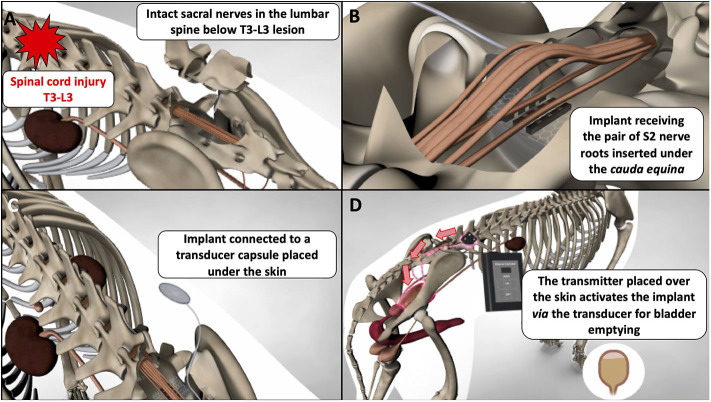
Schematic demonstrating placement and function of a canine sacral nerve stimulator for bladder emptying in chronically paraplegic dogs; (A) in dogs with T3-L3 spinal cord lesions, the sacral nerves below the lesion remain intact and can be accessed via lumbo-sacral laminectomy; (B) a “book” electrode containing two gutters can receive a pair of sacral nerves (e.g., the S2 pair) when the implant is slotted underneath the dural cone and cauda equina; (C) the implant is connected via a cable (named a Cooper cable) to a sub-cutaneous transducer that can be palpated by the clinician and the owner; (D) the transducer is activated with a remote system brought close to the skin and the transducer; this generates an electrical current that flows to the implant, stimulate the sacral nerves, and leads to efficient bladder emptying.